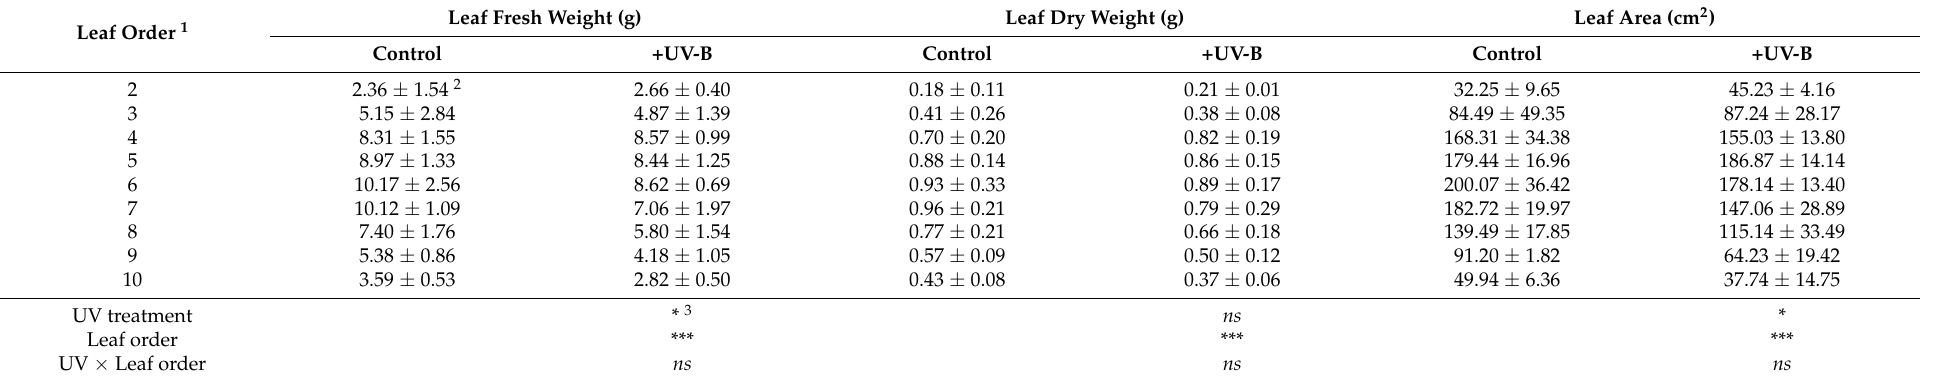
Table 2. Growth parameters of individual kale leaves grown under the control and UV-B exposure conditions for 2 days before harvest.